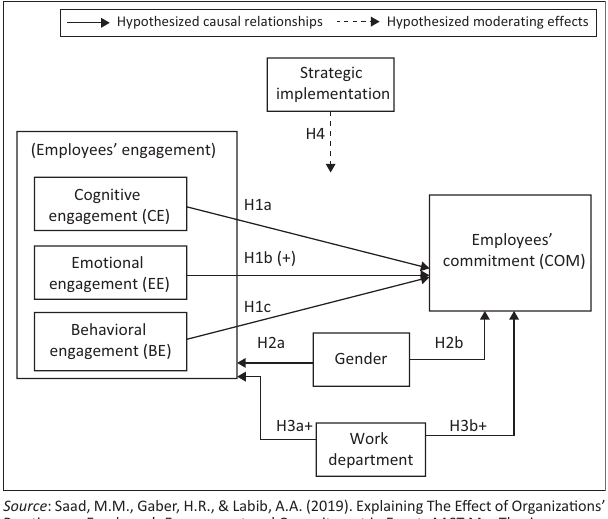
FIGURE 1: Conceptual model – The impact of employees’ engagement on employees’ commitment.